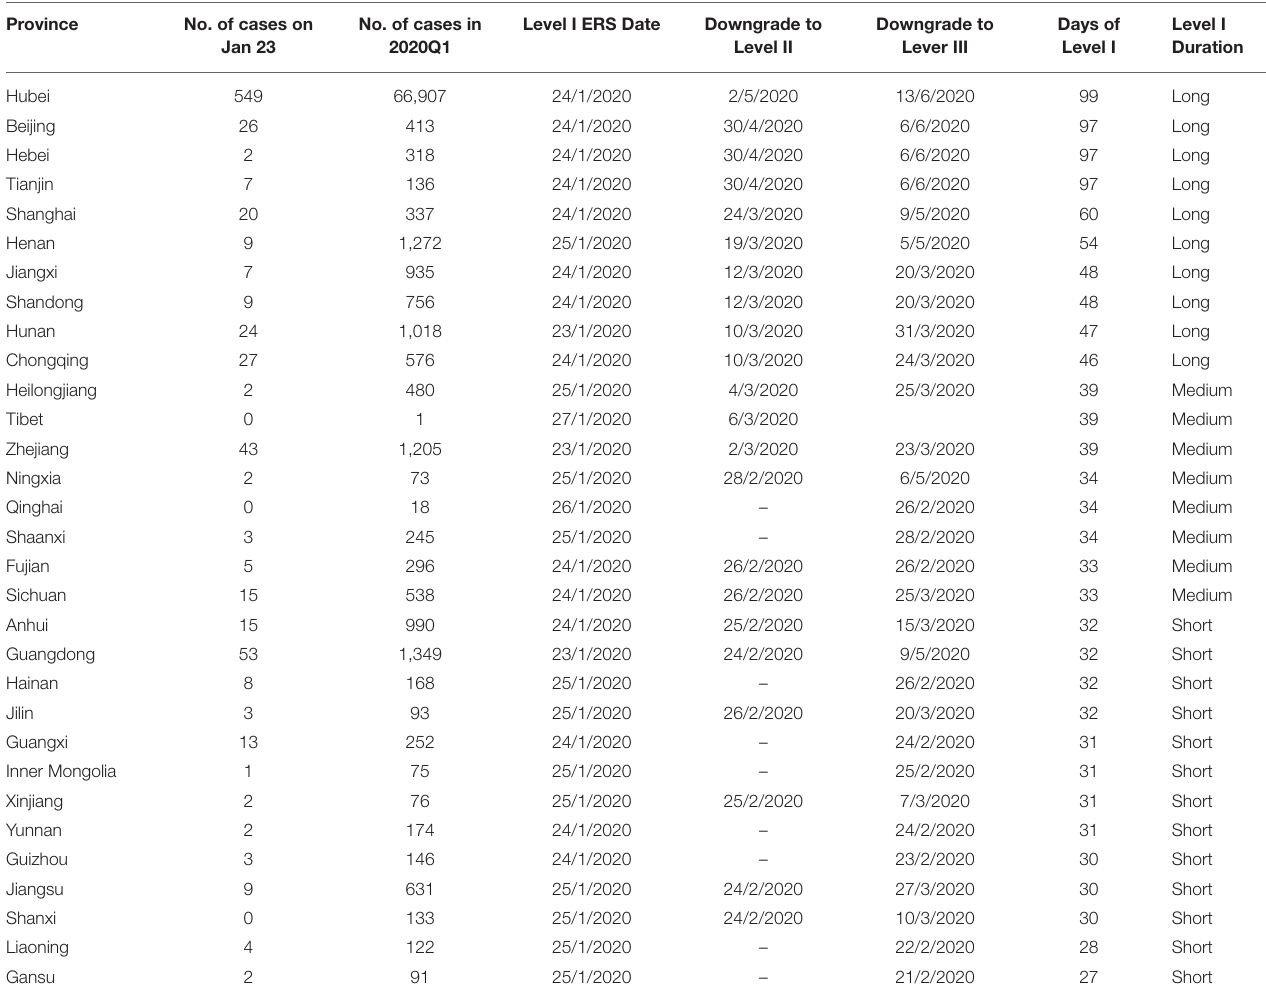
TABLE 1 | The numbers of confirmed cases, ESR announcement dates, and durations of Level I ERS in 31 provinces. Province No. of cases on Jan 23